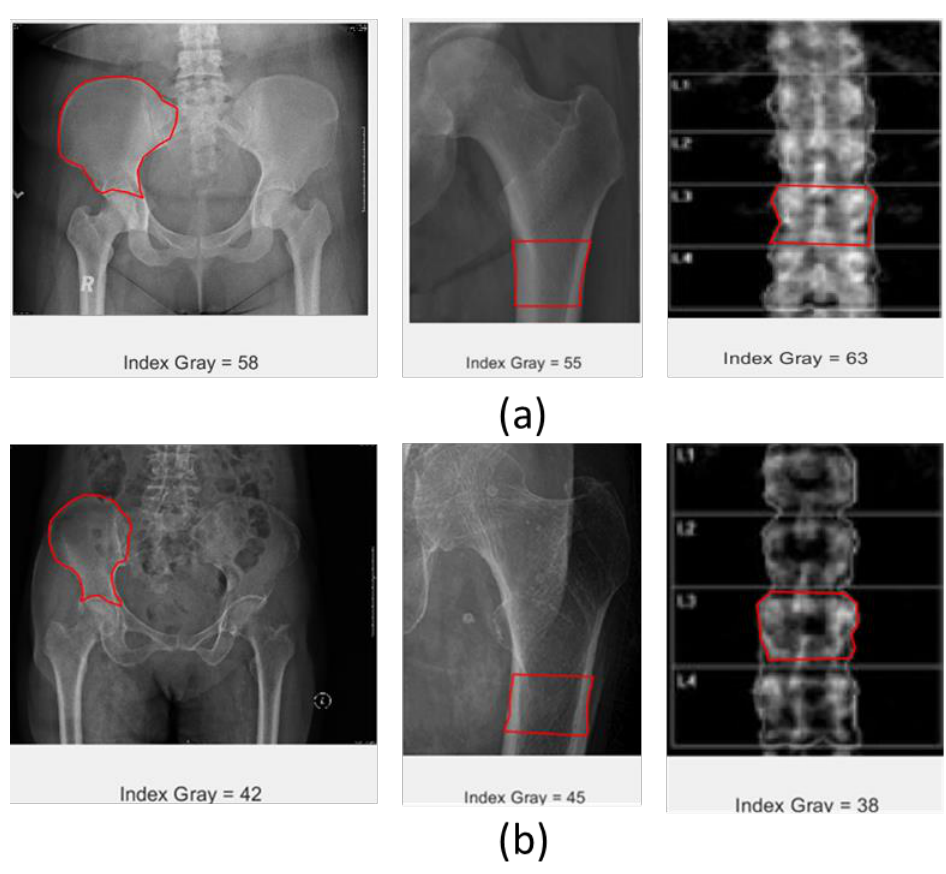
Figure 3. Grayscale index of different image data of pelvic (left), hip (middle), and lumbar spine (right); ( a ) normal bone and ( b ) osteoporotic bone, red box indicates a selected ROI .